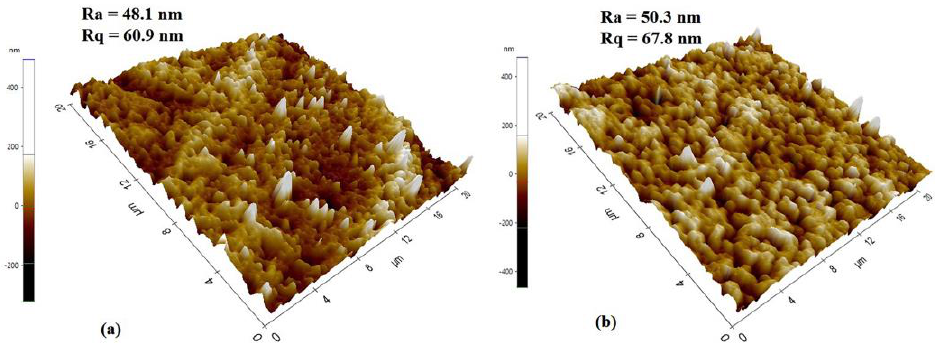
Figure 8. AFM scan images of ( a ) gel and ( b ) resin membranes.